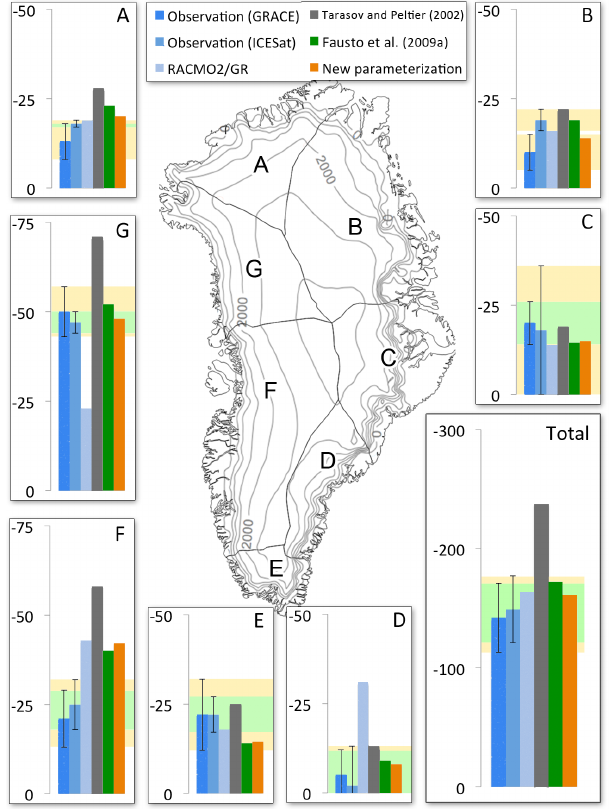
Fig. 5. Modeled versus “observed” SMB trends of the GIS (Gtyr − 1 ) (2003–2009 relative to the reference period). The “ob- served” trends (dark blue) are estimated using the satellite-derived ice mass trends (Sasgen et al., 2012) corrected for the satellite- derived ice discharge contribution (Rignot and Kanagaratnam, 2006; Rignot et al., 2011; see Sect. 3.2.2 for detail). Error bars for the GRACE and ICESat satellite-derived estimates are adopted from Sasgen et al. (2012) and depicted by a light yellow shading, with the overlapping interval marked by a light green shading. Mod- eled SMB trends are from RACMO2/GR (Ettema et al., 2009; light blue) and SICOPOLIS simulations using the parameterizations of Tarasov and Peltier (2002) (dark grey), Fausto et al. (2009a) (green) and our new parameterization with spatially and seasonally variable SD (orange).